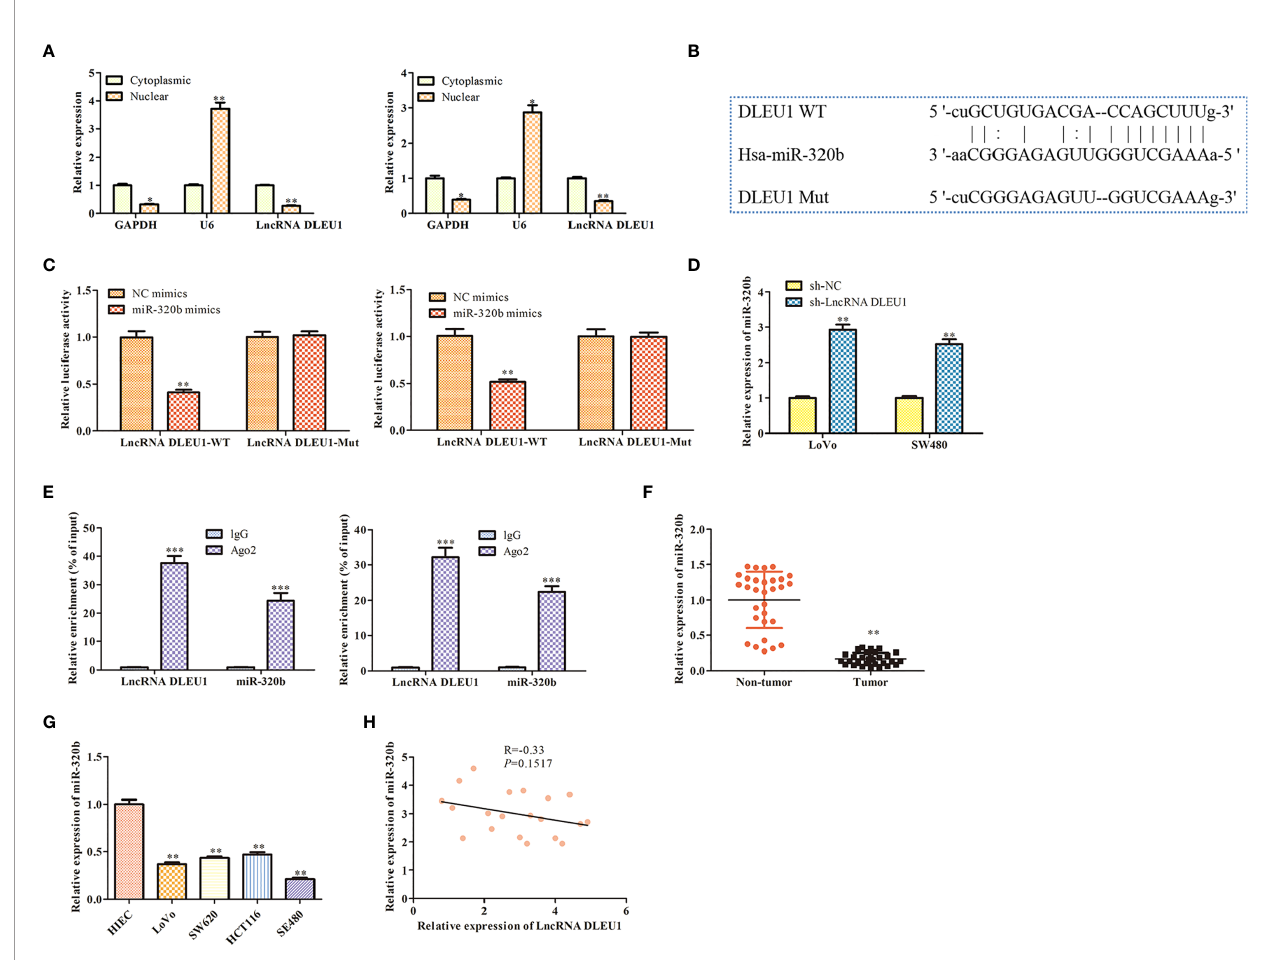
FIGURE 4 | DLEU1 interacts with miR-320b in CRC. (A) The levels of DLEU1 in the nuclear and cytoplasm of both LoVo and SW480 cells were determined using qRT-PCR after subcellular fractionation assay, * P < 0.05, ** P < 0.01 vs . cytoplasmic. (B) DLEU1 interacted with miR-320b via bioinformatics analysis. (C) DLEU1 interacted with miR-320b using dual luciferase reporter assay, ** P < 0.01 vs . NC mimic. (D) The levels of miR-320b was determined using qRT-PCR, ** P < 0.01 vs . sh-NC. (E) Relative enrichment of DLEU1 and miR-320b in LoVo and SW480 cells was determined using RIP assay, *** P < 0.001 vs . IgG. (F) The relative expression of miR-320b was determined by qRT-PCR in non-tumor and CRC tissues, ** P < 0.01 vs . non-tumor tissues. (G) The relative expression of miR-320b was determined by qRT-PCR in CRC cell lines, * P < 0.05, ** P < 0.01 vs . HIEC. (H) The correlation between DLEU1 and miR-320b was assessed using Pearson ’ s correlation